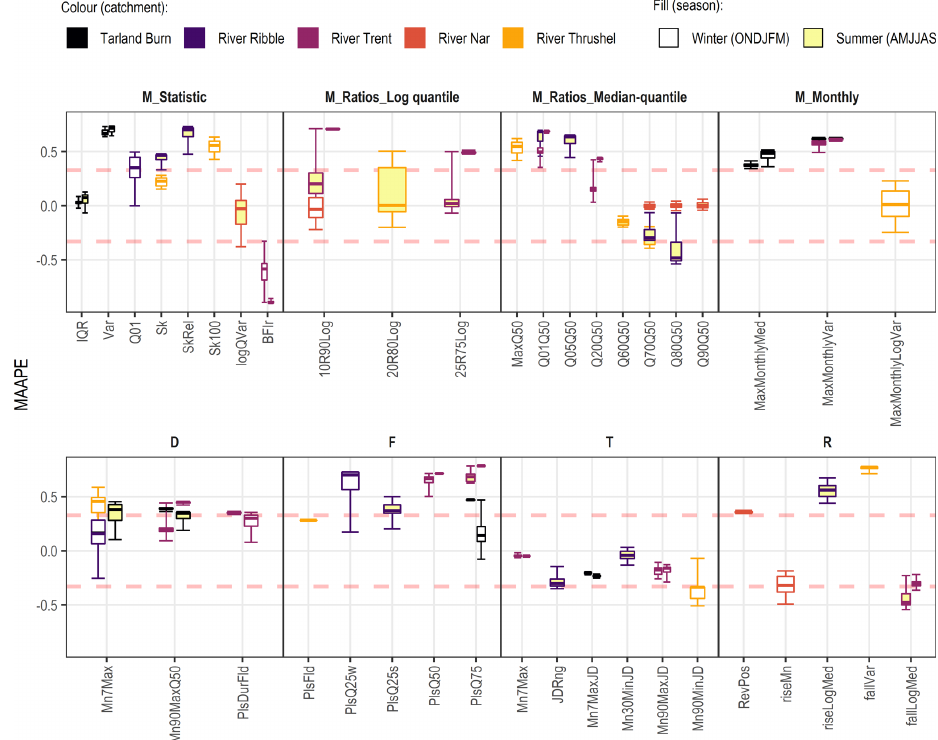
Figure 4. Mean arctangent absolute percentage error (MAAPE) values for each ER HI; ER HIs are grouped by facet of the flow regime: magnitude ( M ), duration ( D ), frequency ( F ), timing ( T ) and rate of change ( R ). As per HAF, the acceptable range is defined as ± 0 . 33 (red dashed line). The four- and five-parameter results are adjacent, left and right respectively, for the Tarland Burn and River